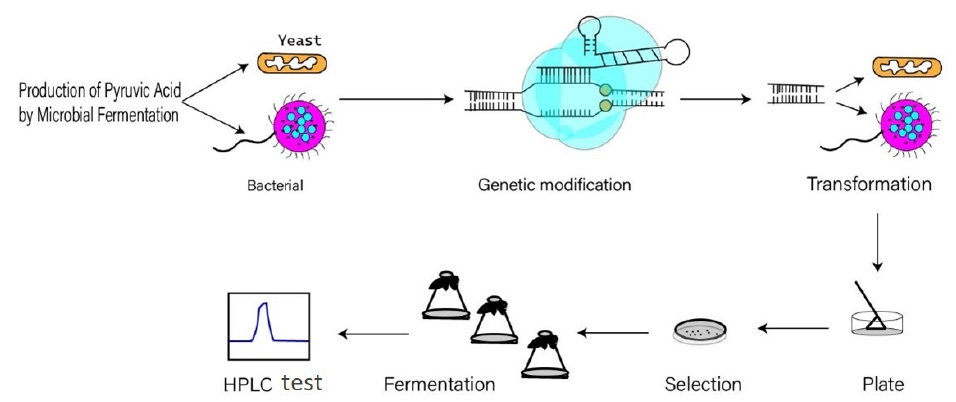
Figure 1. Pyruvic acid production process by microbial fermentation.